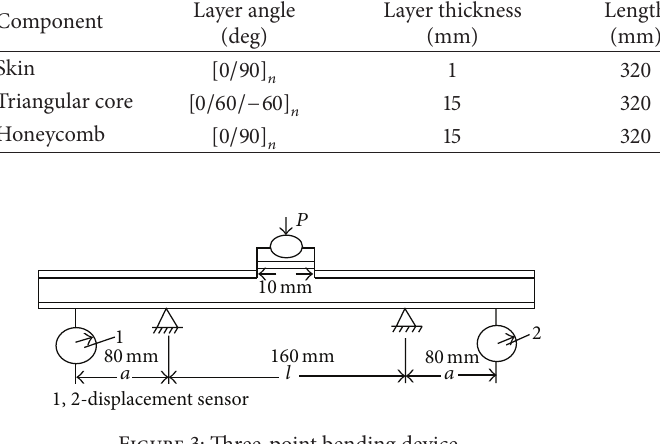
Figure 3: Three-point bending device.